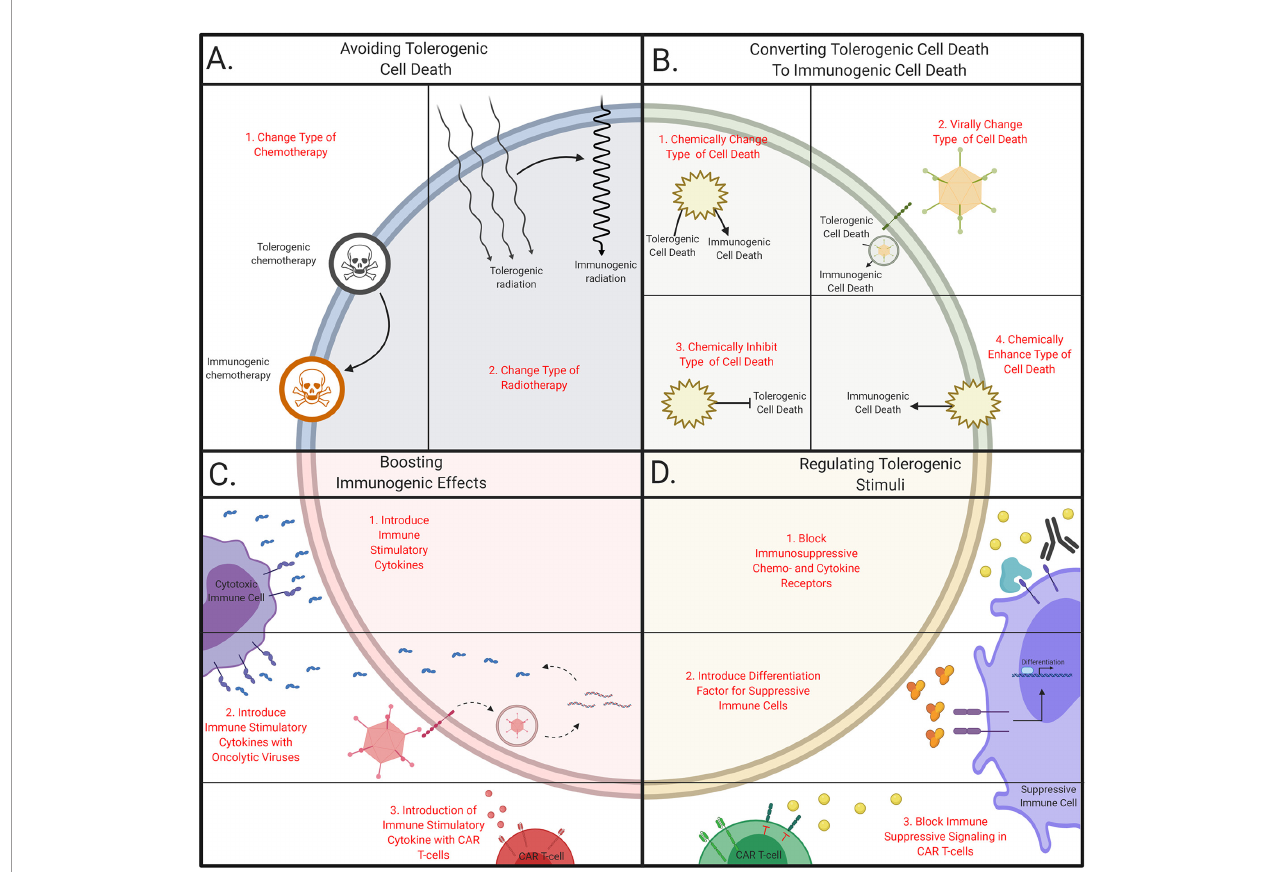
FIGURE 2 | Schematic overview of tailoring therapeutic strategies to avoid tolerogenic cell death. (A) Avoiding tolerogenic cell death. Immunogenic cell death can be induced by (1) changing chemotherapeutic agents or (2) changing dose and regimes in radiotherapy. (B) Converting tolerogenic cell death to immunogenic cell death. Immunogenic cell death can be initiate by (1) chemically or (2) virally changing the cell death pathway, (3) chemically inhibiting tolerogenic pathways or (4) chemically stimulate immunogenic cell death. (C) Boosting immunogenic effects. Immunogenicity can be boosted via (1) the introduction of cytokines directly or via the delivery with (2) oncolytic viruses or (3) CAR T cells. (D) Regulating tolerogenic stimuli. Tolerogenic stimuli can be inhibited with (1) antibodies, (2) immune suppressive cells can be forced into differentiation or (3) T cells can be engineered to become resistant to tolerogenic stimuli. This fi gure was created by authors using Biorender tools